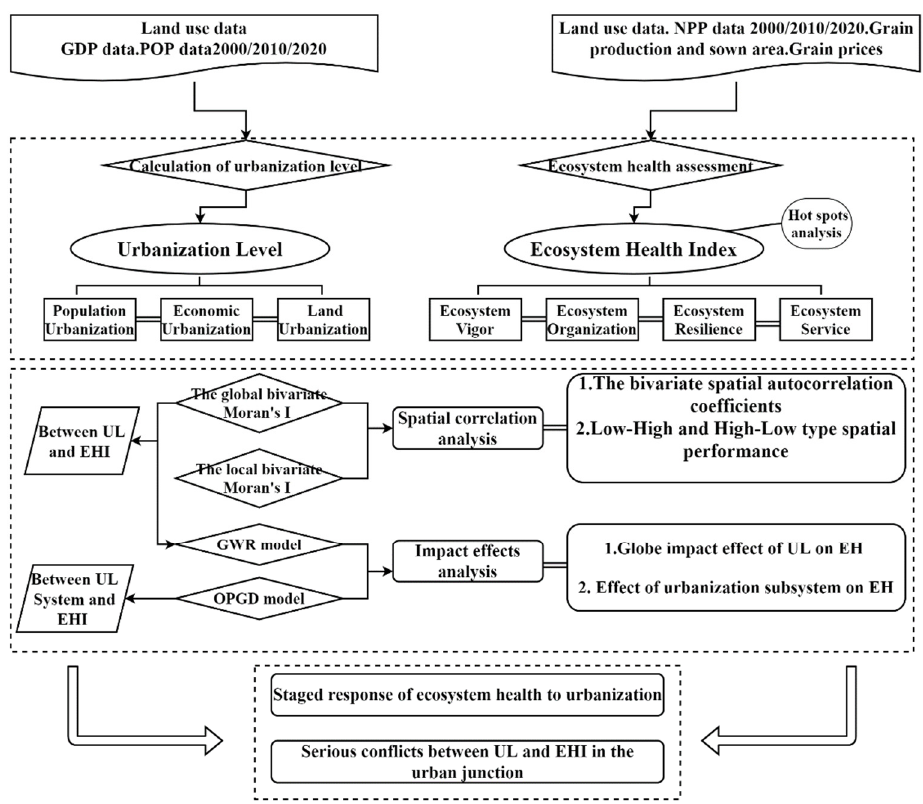
Figure 2. Research framework.